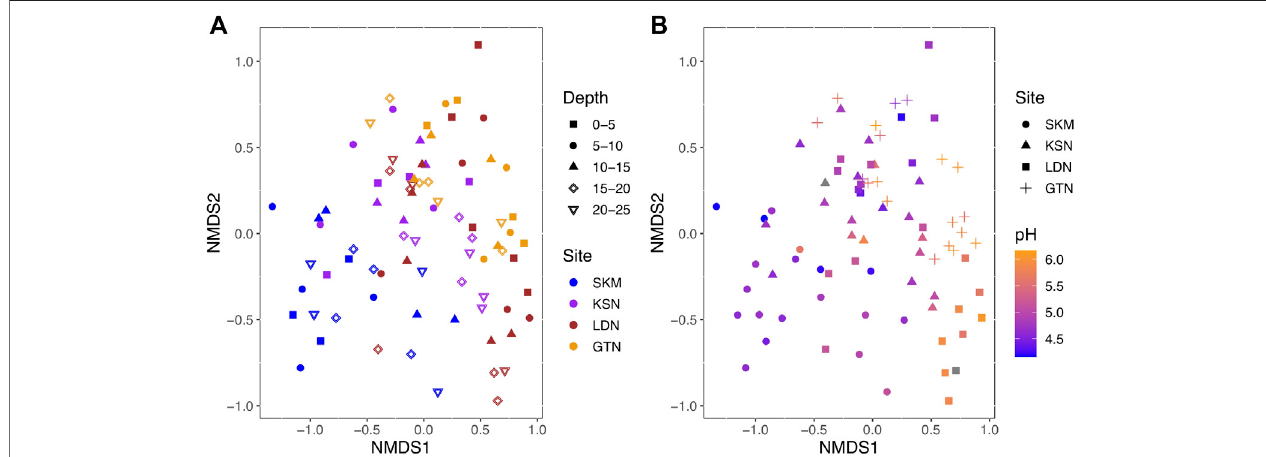
FIGURE 2 | Relative abundance (%) of most abundant order-level groups of hgcA+ microorganisms in four studied wetlands based on high throughput hgcA amplicon sequencing [ (A) Unclassi fi ed; (B) Unclassi fi ed Bacteria; (C) OPB41 (Actinobacteriota phylum); (D) Desulfuromonadales; (E) Desulfovibrionales; (F) Methanosarcinales, (G) Syntrophales, and (H) Syntrophomonadales.